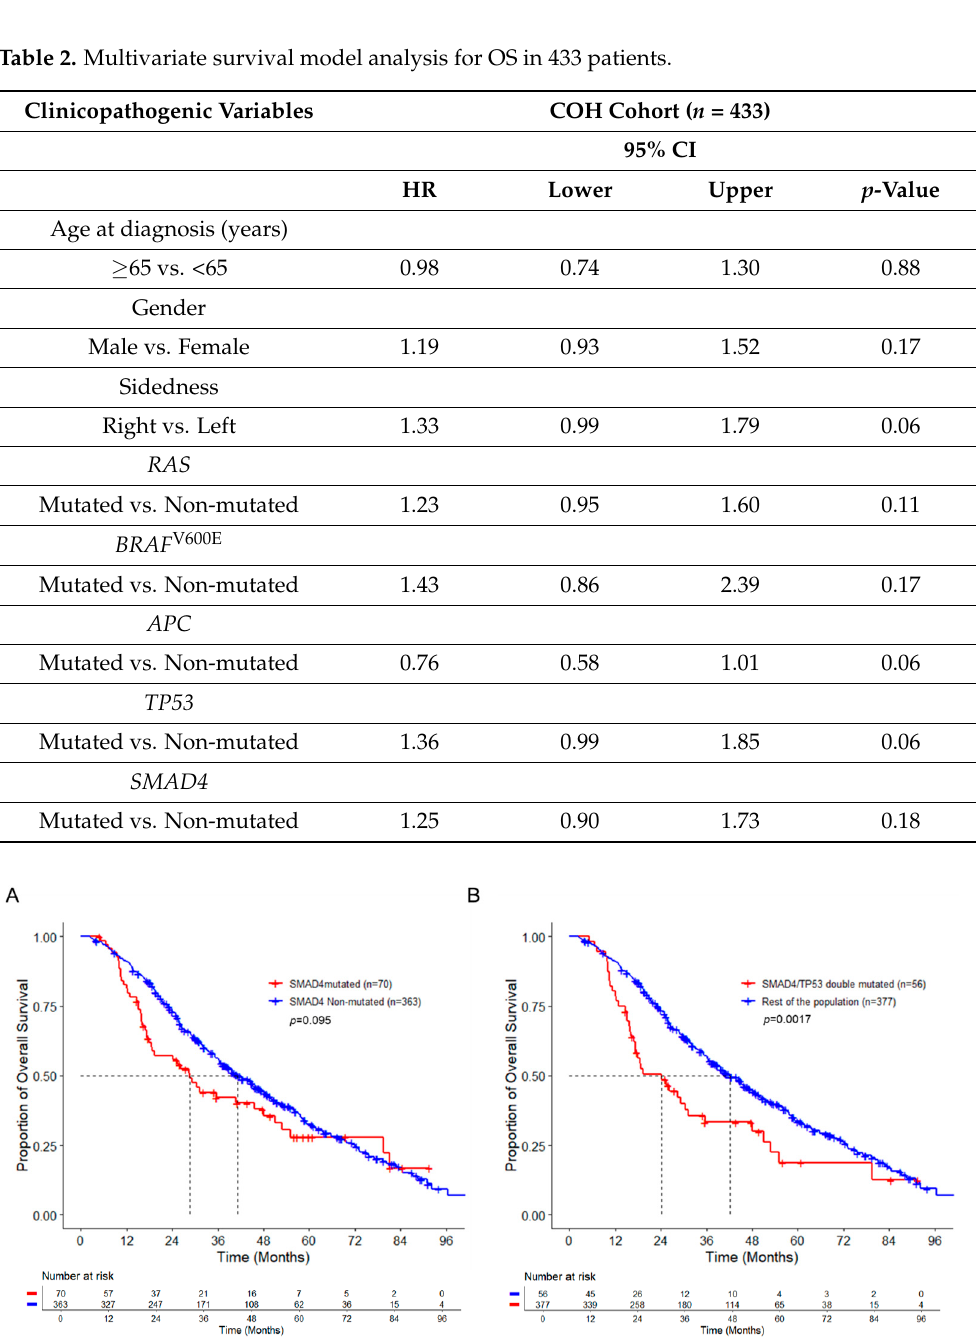
Figure 2. Kaplan–Meier curves for overall survival of metastatic colorectal cancer patients by SMAD4 and TP53 status. ( A ), Red line, Kaplan–Meier curve of overall survival for patients with SMAD4 mutation; Blue line, Kaplan–Meier curve of overall survival for patients without SMAD4 mutation. ( B ), Red line, Kaplan–Meier curve of overall survival for patients with SMAD4 and TP53 double mutation; Blue line, Kaplan–Meier curve of overall survival for patients without SMAD4/TP53 double mutation. Table 2. Multivariate survival model analysis for OS in 433 patients.